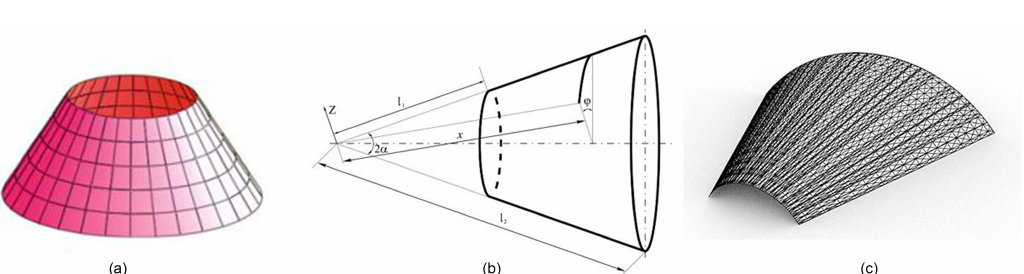
plane z = 0 (a rise); l is a distance between planes with directrix hyperbolas; ch is a hyperbolic